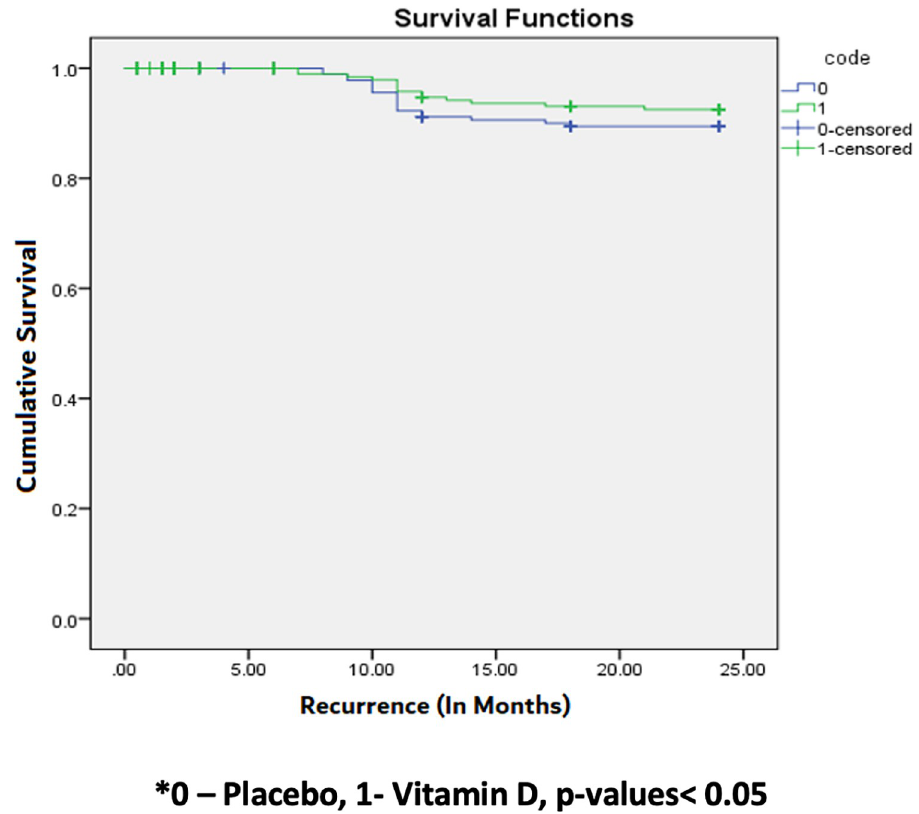
Fig 2. Kaplan Meier graph presenting time to relapse in both the groups. Shows number of relapses in both vitamin D and placebo groups. There are more relapses in the placebo group but the difference is not statistically significant (p- value 0.290).